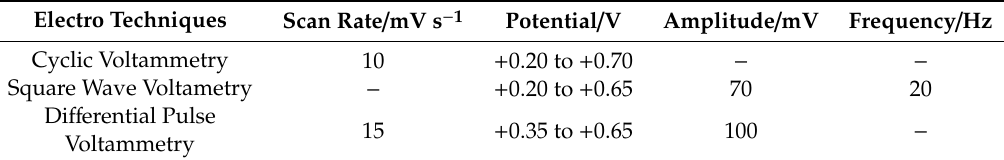
Table 4. Optimized operational parameters and comparative study of CV, SWV and DPV sensitivity for the determination of EE (0.1 mol L − 1 of Phosphate bu ff er pH 7).